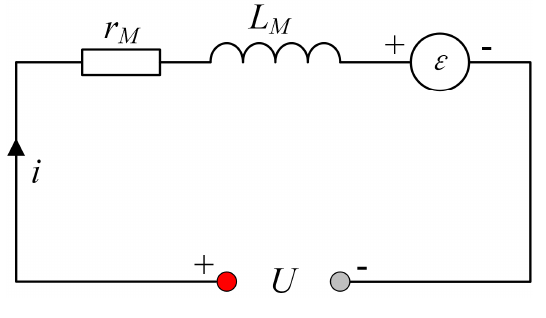
Figure 8. Equivalent circuit of the LEM.